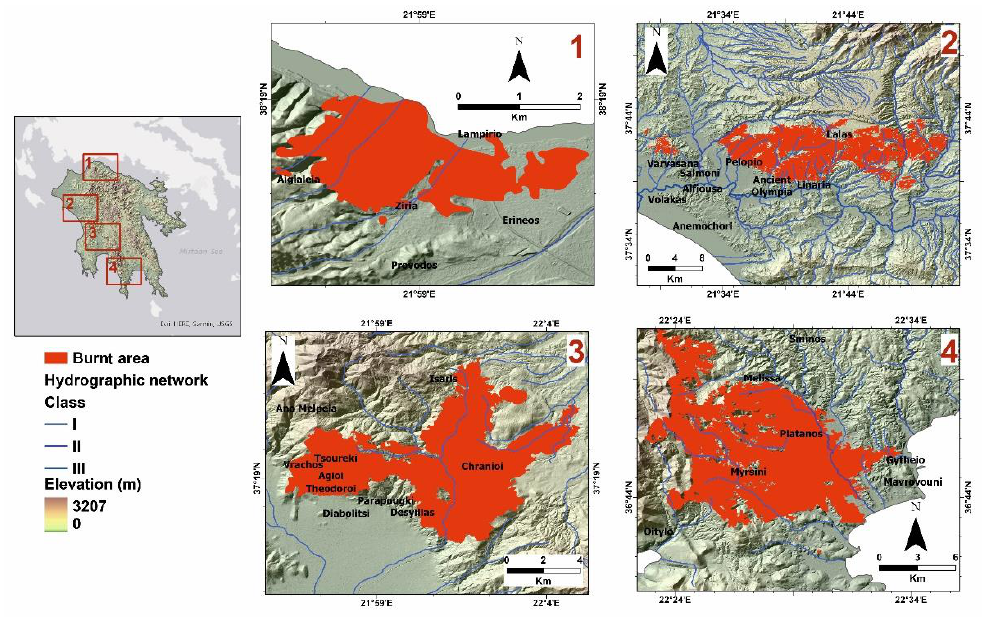
Figure 7. The fire-affected areas in the Peloponnese.